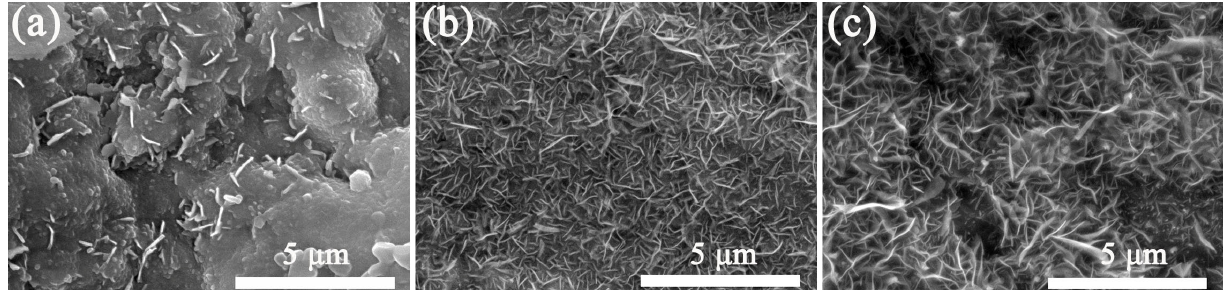
Figure 4. SEM images of VGNs/CF composite films prepared at 850 °C using the glucose solution with different concentrations of ( a ) 0.2 g/mL, ( b ) 0.4 g/mL, ( c ) 0.6 g/mL, respectively.